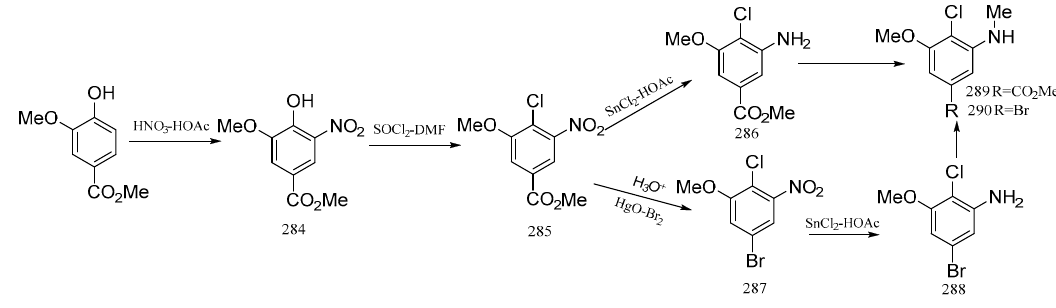
Figure 11. The synthetic by-products of the southern fragments of maytansine.